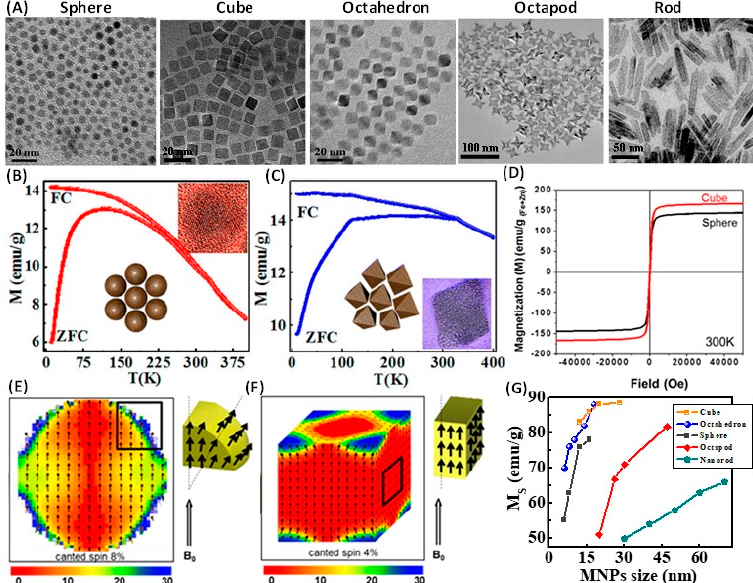
Figure 12. ( A ) TEM images of Fe 3 O 4 spheres (8 nm), cubes (12 nm) [115], octahedrons (10 nm) [68], octopods [116] and rods [69] are obtained through thermolysis of iron salt. FC and ZFC magnetization curves of ( B ) spherical and ( C ) octahedral Fe 3 O 4 nanoparticles at the applied field of 200 Oe [68]. ( D ) Room temperature M-H curves of cube and sphere-shaped Fe 3 O 4 nanoparticles [2]. Simulated magnetic spin structures of ( E ) cube and ( F ) sphere. The color map indicates the degree of spin disorder in an external magnetic field, where red indicates ordered spins and blue indicates disorder spins. The right corners of parts E and F show their local surface spin arrangements [2]. ( G ) The variation of M S of di ff erent anisotropic Fe 3 O 4 with increase of size